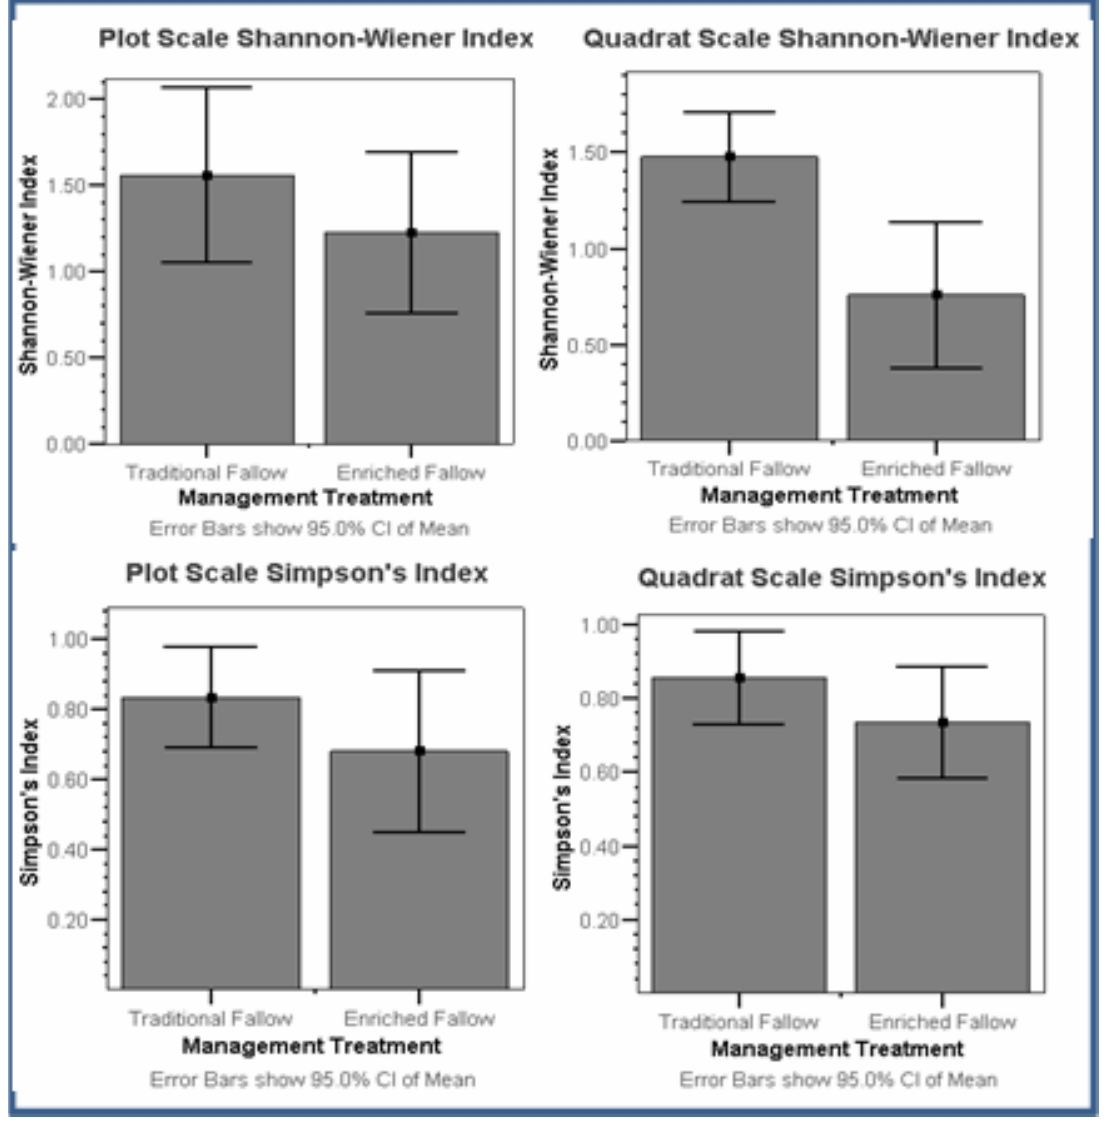
Fig. 6. Shannon-Wiener and Simpson’s indices of diversity at plot (dbh>5 cm) and quadrat (dbh>1 cm)